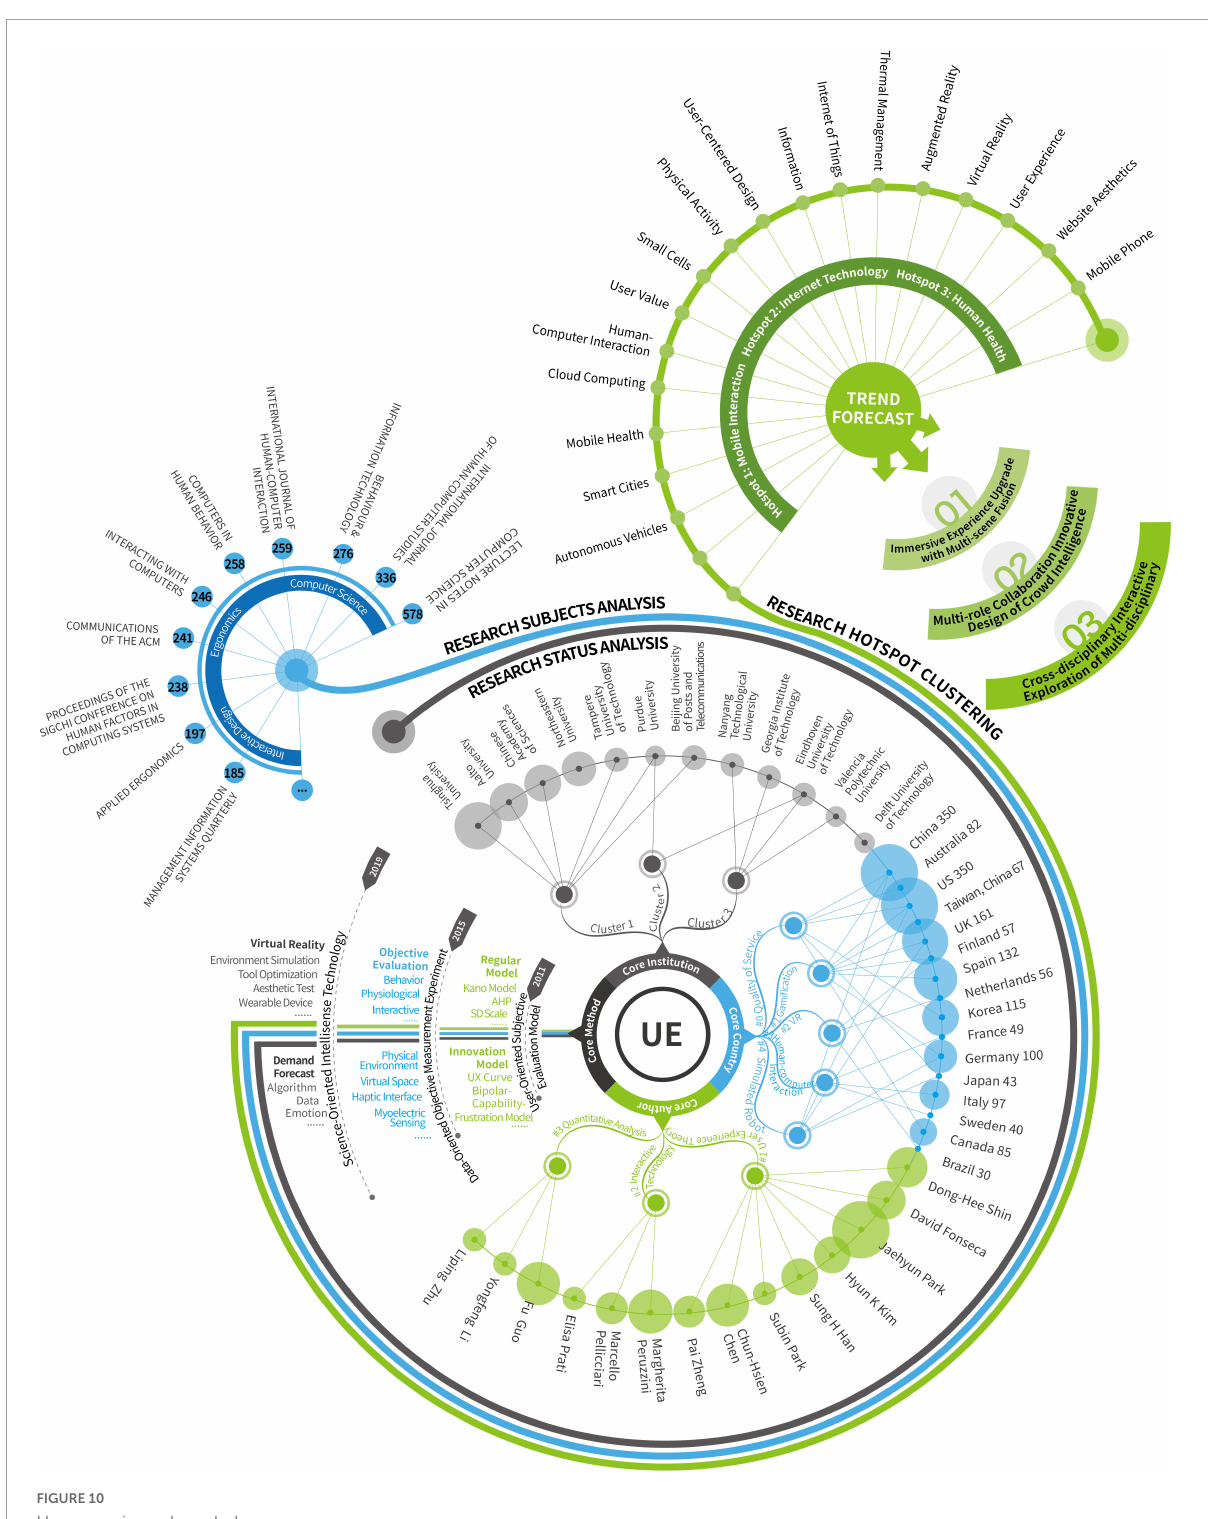
FIGURE10 User experience knowledge